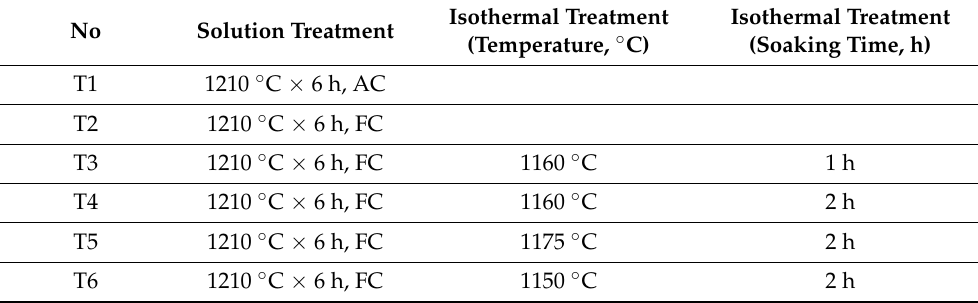
Figure 1. The equilibrium phase diagram of GH4975 alloy obtained by thermodynamic calculation. Table 2. The processes of solution treatment and isothermal treatment of GH4975 alloy.